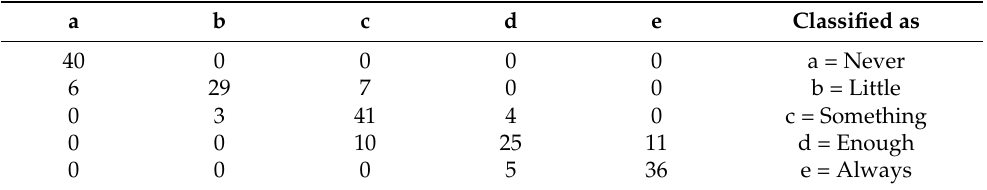
Table 18. Results obtained from the confusion matrix by people classified correctly and incorrectly and the identification of the number of surveys that did not respond to the study